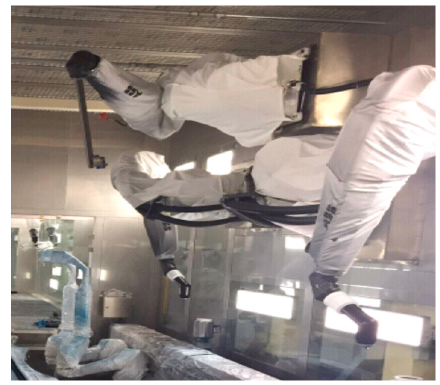
Electronics 2019 , 8, x FOR PEER REVIEW